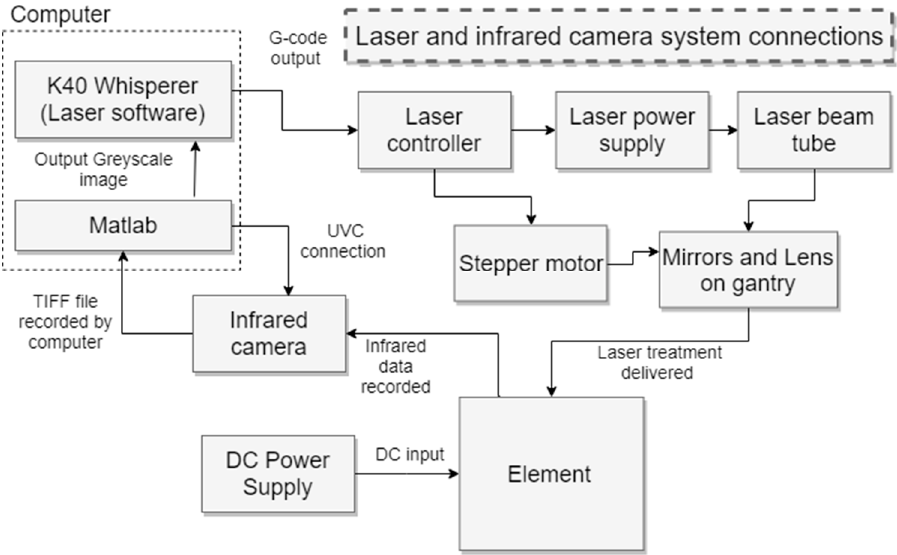
Figure 11. Connection of the components within the laser system.